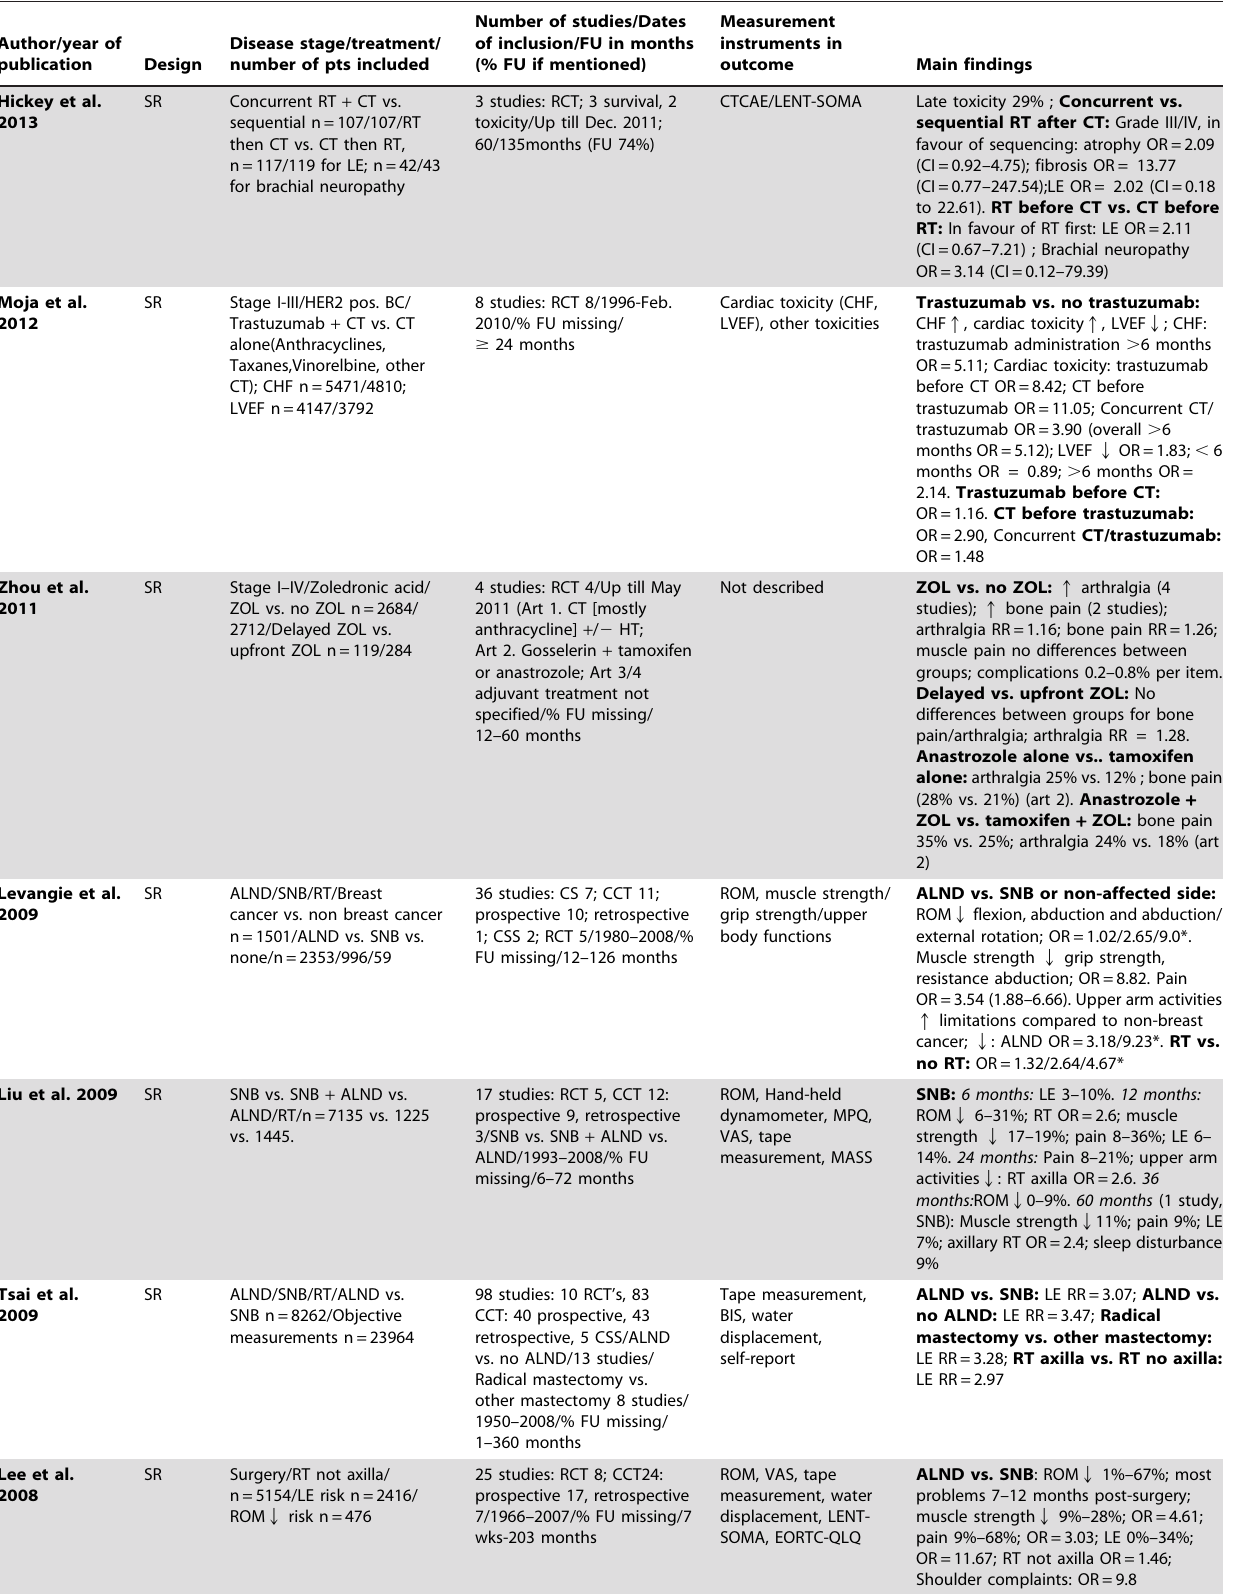
Table 2. Outcome of the studies regarding breast cancer treatment and adverse